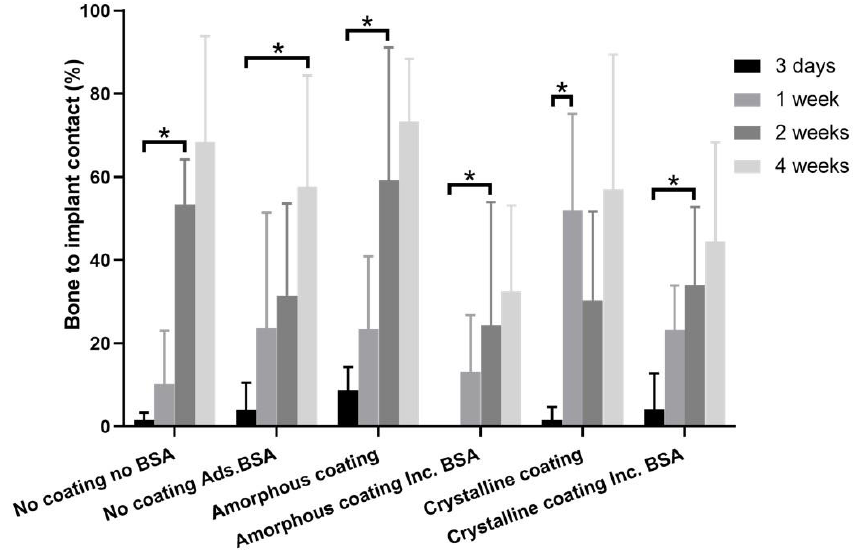
Figure 7. Graph depicting histomorphometric analysis of bone to implant contacts (BICs) of mini-pin implants from different groups, which were implanted in the rat tibia for 3 days, 1 week, 2 weeks, and 4 weeks. Mean values (n = 6 for each group) were presented together with the standard deviation (* p < 0.05).